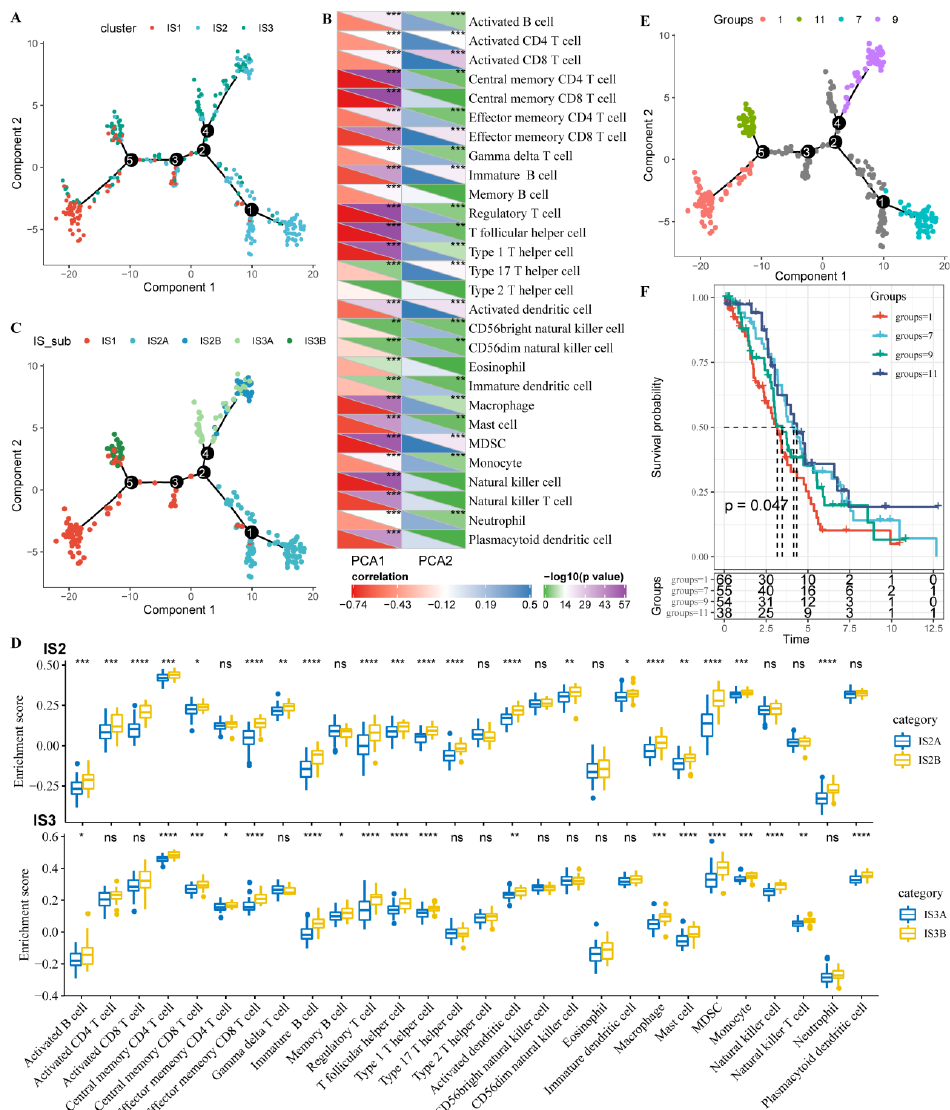
Figure 7. Immune landscape of OC. ( A ). Immune landscape of OC. Each point represents a sample, different colors represent different molecular subtypes, the horizontal axis represents the first principal component, and the vertical axis represents the second principal component. ( B ). Heatmap of two principal components with 28 TIICs. ( C ). Immune landscape of the subsets of OC immune subtypes. ( D ). Differential enrichment scores of the 28 TIICs in the above subsets. ( E ). Immune landscape of OC. ( F ). Prognostic differences based on the OC immune landscape. * p < 0.05; ** p < 0.01; *** p < 0.001; **** p < 0.0001, and ns, no significance.